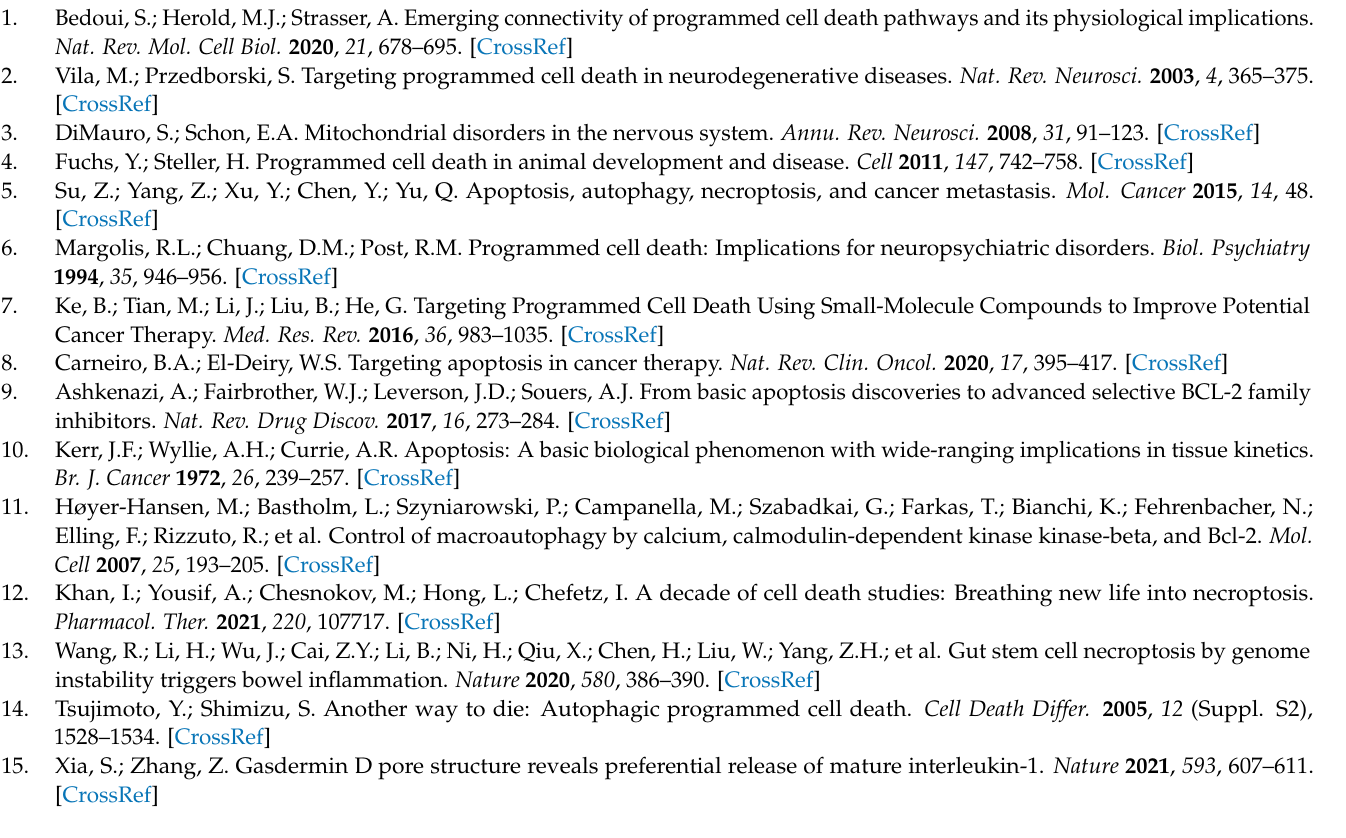
Table S3: The detailed summary of 30 PCD forms; Table S4: The 102 public resources of 16 anno- tation aspects; Table S5: The distribution of regulatory proteins and corresponding PCD forms in 562 eukaryotes; Table S6: The data statistics of experimentally identified proteins for 30 PCD forms in 8 model organisms; Table S7: The data statistics of human regulators involved in different forms of